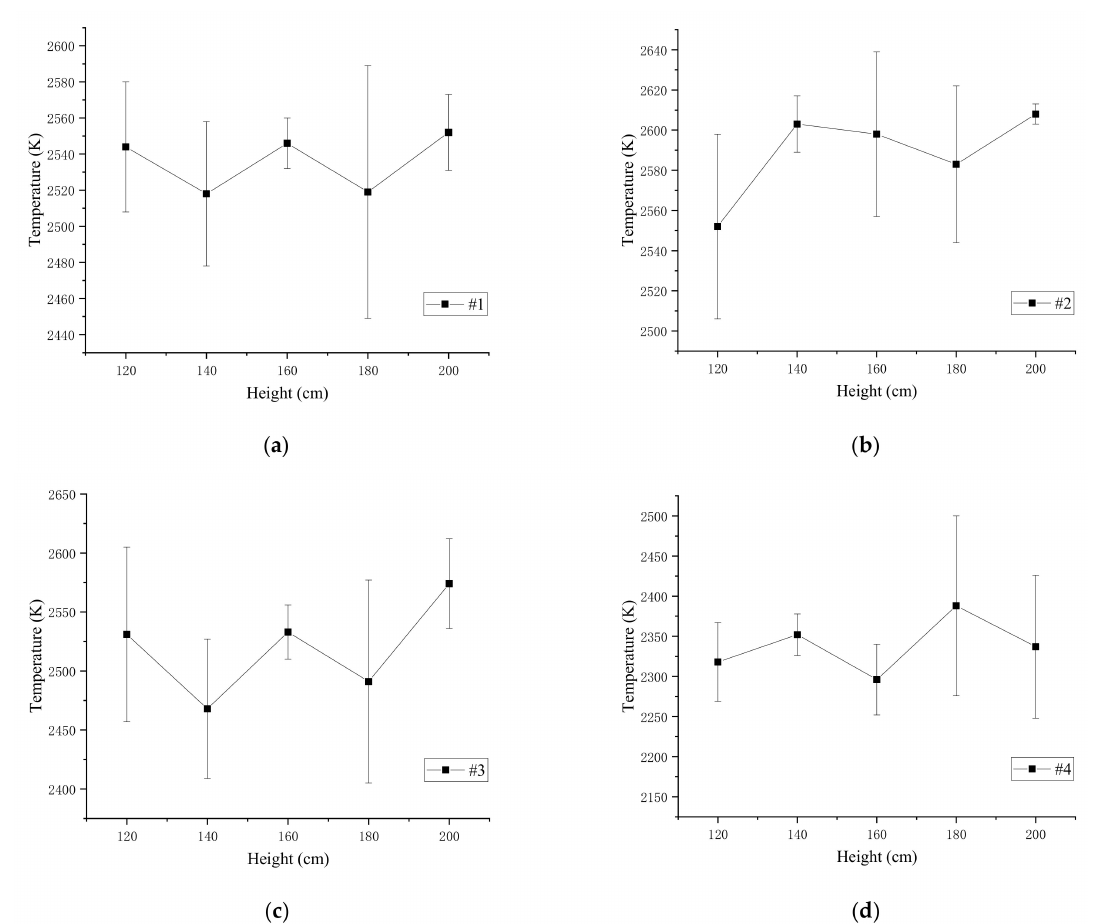
Figure 7. The average flame temperature and standard deviation of the four samples: ( a ) average temperature and standard deviation of #1; ( b ) average temperature and standard deviation of #2; ( c ) average temperature and standard deviation of #3; ( d ) average temperature and standard deviation of #4.